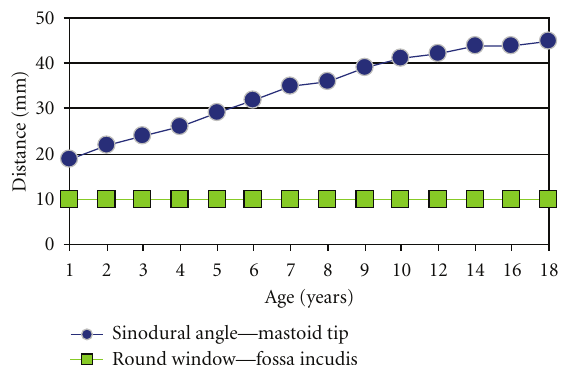
incudisSinodural angle—mastoid tip Round window—fossa Figure 5: Growth of the middle ear versus mastoid: the mastoid tip develops, whereas the middle ear dimensions remain the same. The distance of the round window to the fossa incudis and facial recess does not change over time, but the mastoid process increases in size. When the electrode is fixed to the mastoid tip, the increasing distance from round window to mastoid tip could cause a possible displacement of the electrode out of the cochlea. Adapted from Dahm et al.